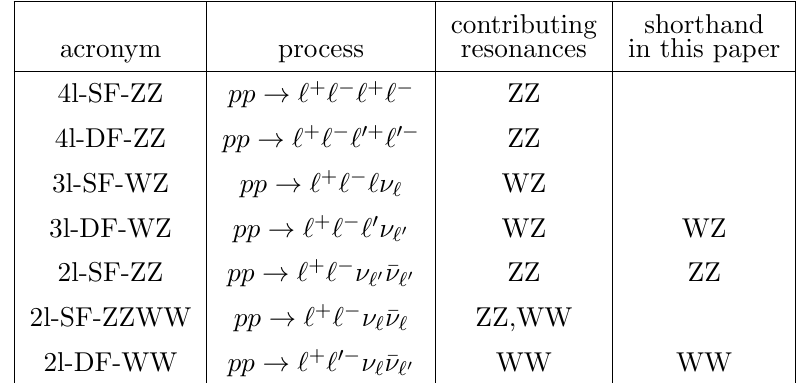
Table 1 . Complete list of diboson processes that are implemented in Matrix and will be upgraded to NNLO QCD+NLO EW accuracy in the forthcoming code release. The last column indicates the shorthands used for the three representative processes presented in this paper. In this table it is implicitly understood that ‘ 0 = ‘ . 6